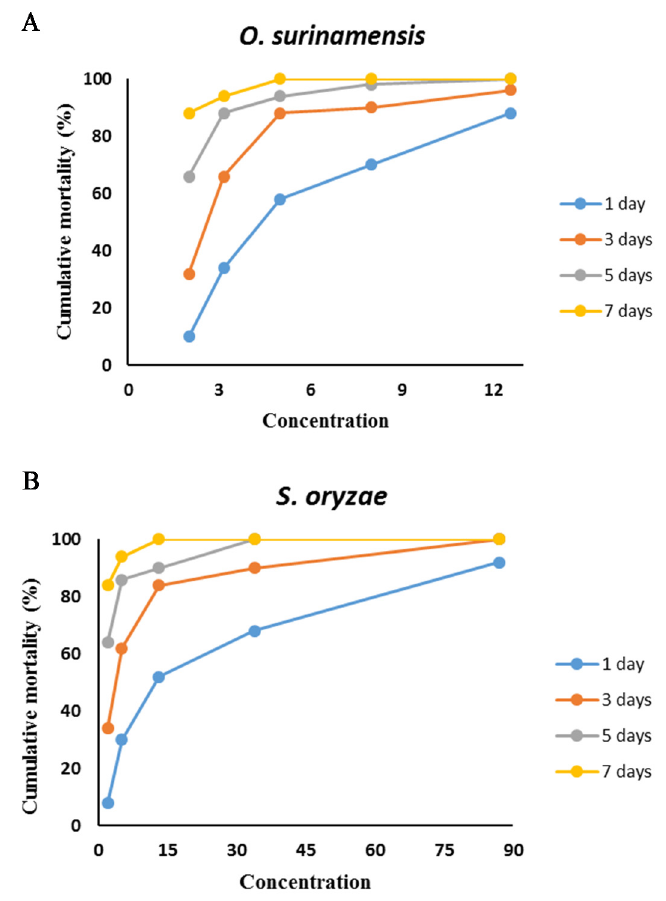
Figure 5. Cumulative mortality of stored pests ( A : O. surinamensis and B : S. oryzae .exposed) to different concentrations of T. kotschyanus essential oil (µL/L air).